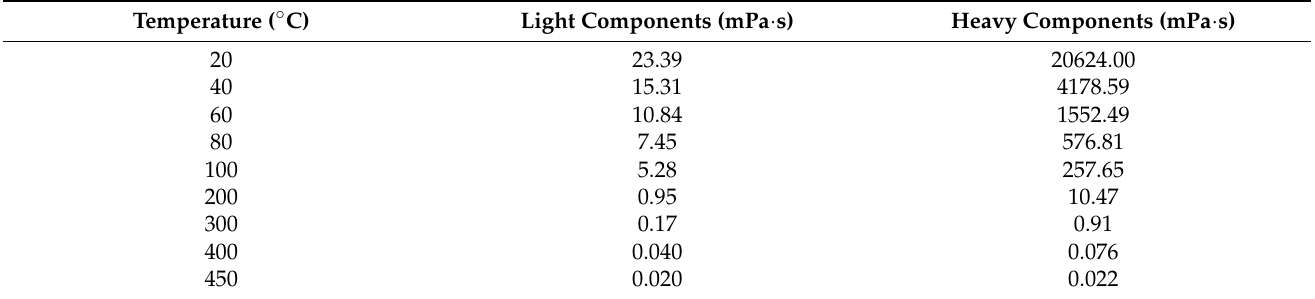
Table 4. Viscosity-temperature